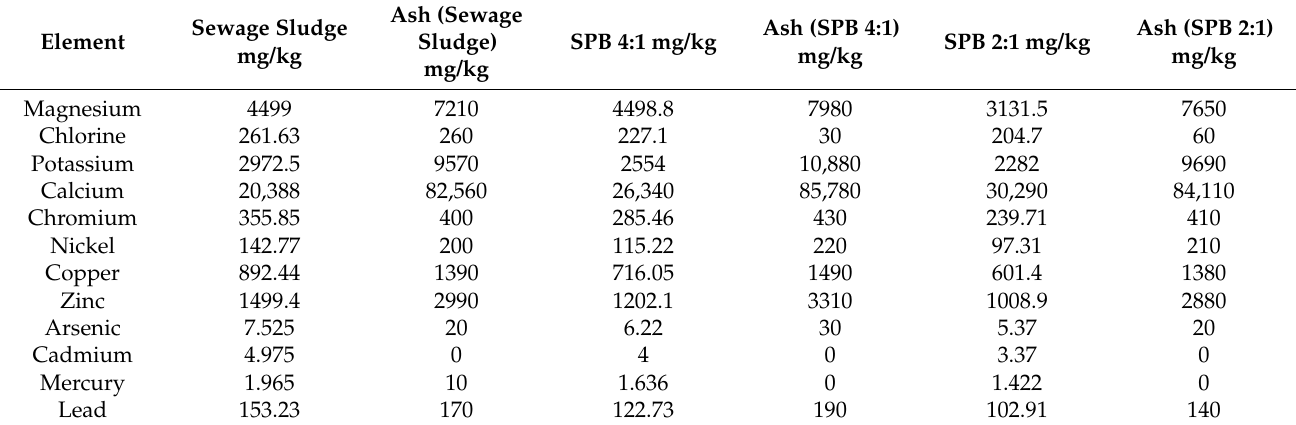
Table 6. Analysis of sewage sludge, SPB 2:1, SPB 4:1, and their ash after combustion.